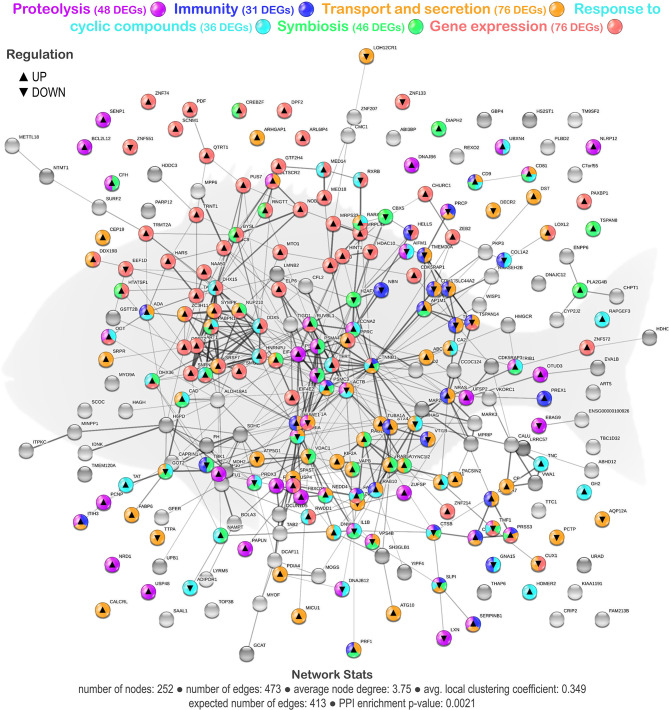
Transcripteractome of the differentially expressed genes (DEGs) in the mid-anterior intestine of juvenile gilthead seabream (S. aurata) fed the garlic, carvacrol, and thymol essential oils (EOs)-supplemented diet (see also Supplementary Tables and Supplementary Figures 2–8). Protein–Protein Interactions Network (PPI) network nodes colors indicate the six representative processes identified from the functional enrichment analysis for each DEG represented—proteolysis, immunity, transport, and secretion, response to cyclic compounds, symbiosis, and gene expression. ▴ nodes represent upregulated genes and ▾ nodes represent downregulated genes. Graphic keys and network stats are indicated in the graphical figure legend.